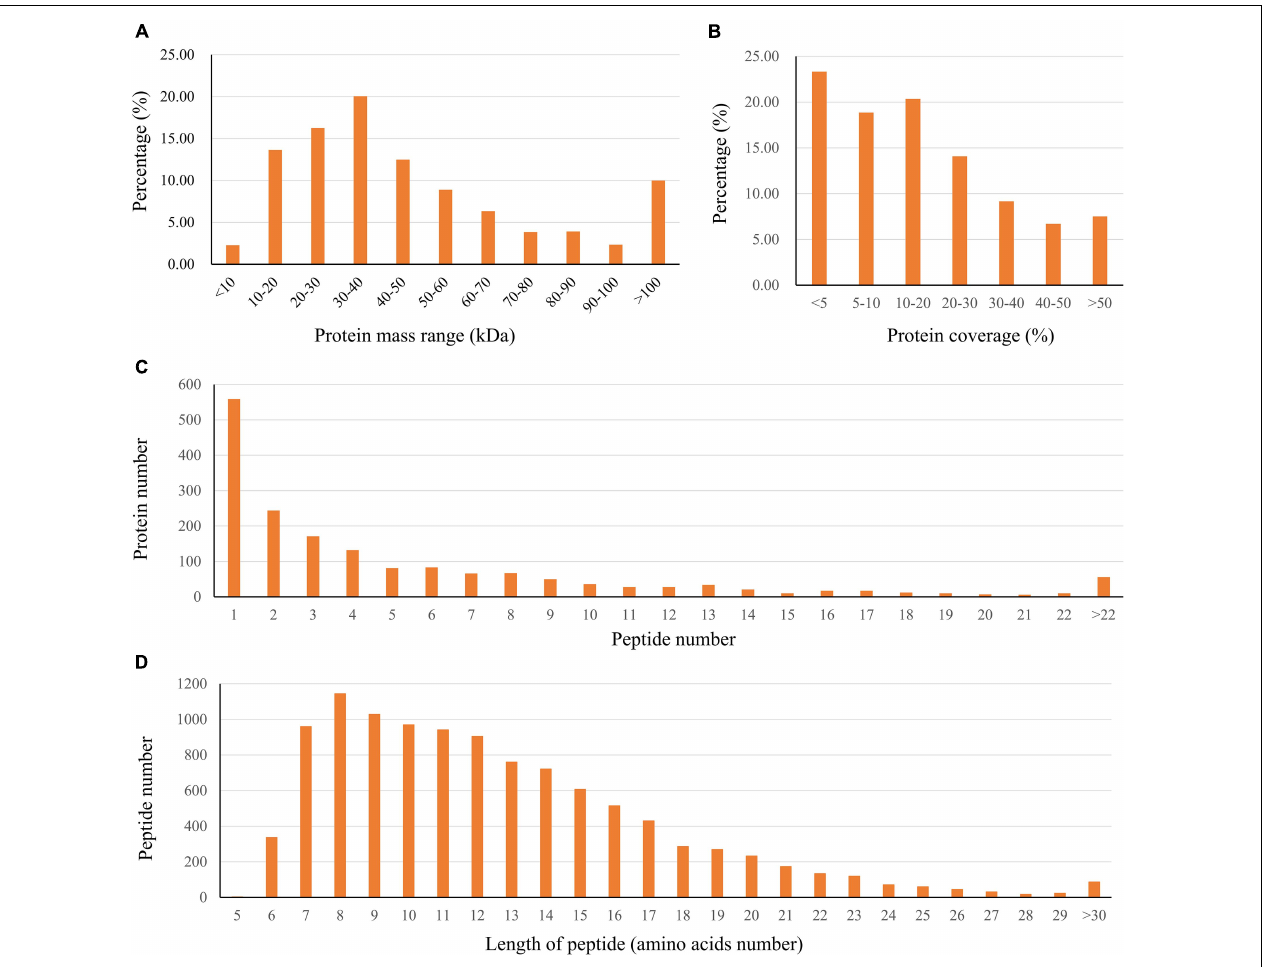
FIGURE 3 | Characteristics of the identified unique peptides in boar sperm samples. (A) The protein mass distribution. (B) The protein coverage. (C) The distribution of unique peptide number. (D) The distribution of peptides based on their